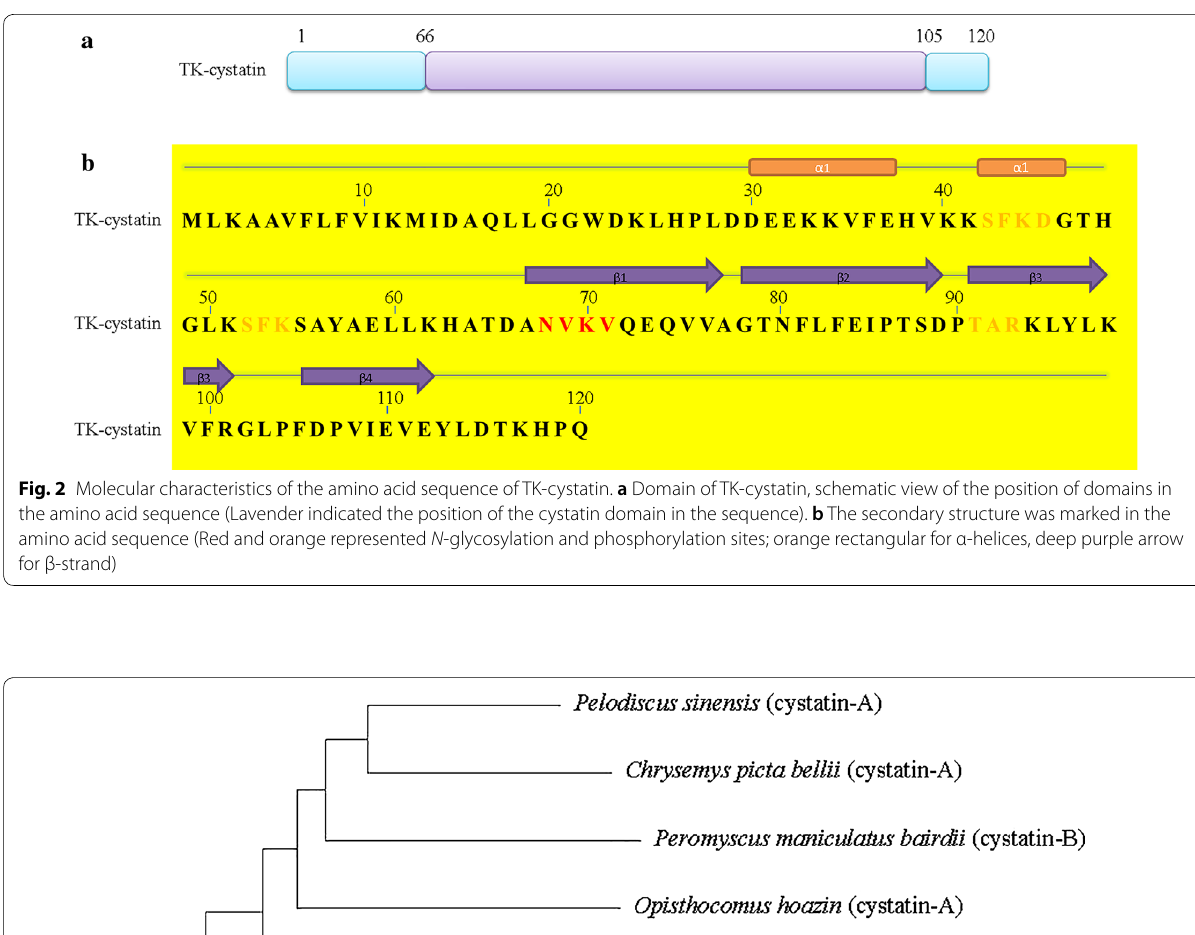
And this indicated that TK-cystatin had a similar struc- ture to cystatinA. The N-terminal conserved region, the hairpin loop 1 region (between β1 and β2) and hairpin loop 2 region (between β3 and β4) together formed the wedge-shaped edge, which was complementary to pro- tease cleavage. The N-terminal G 19 G 20 was indispensable